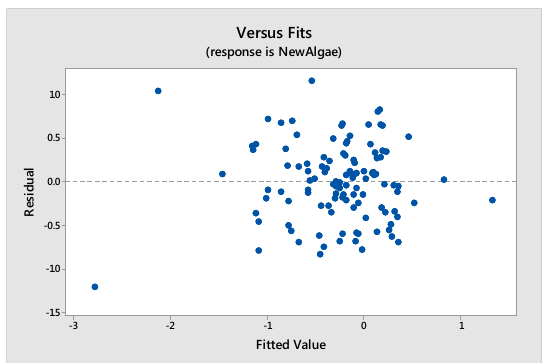
Figure 6. Histogram of residuals. Coatings 2018 , 8 , x FOR PEER REVIEW